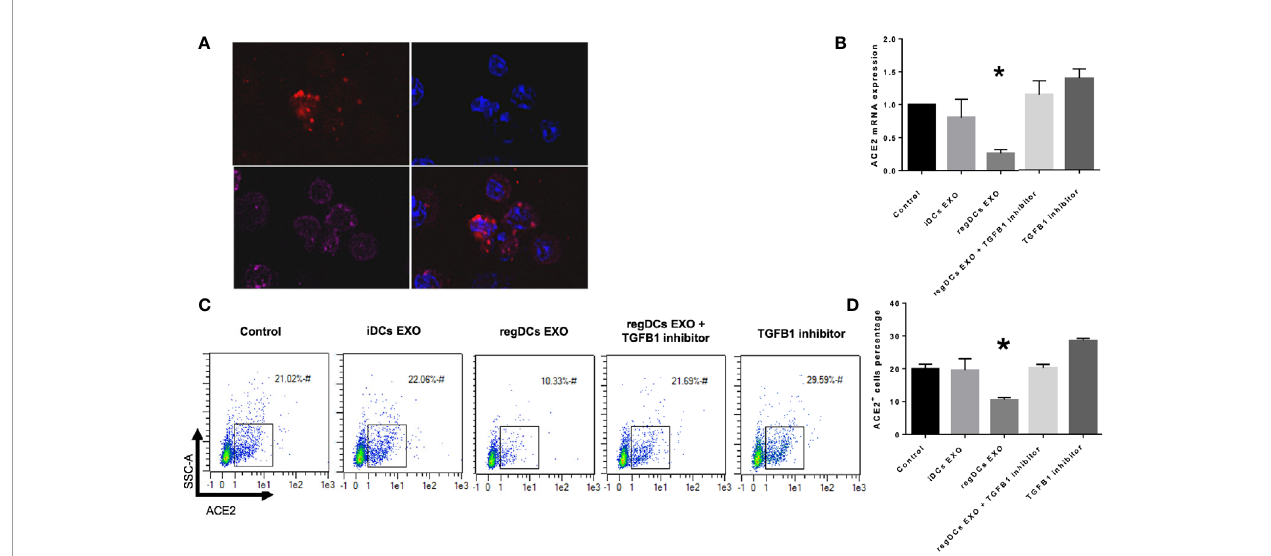
FIGURE 11 | regDCs EXO are taken up by acceptor PBTECs, inhibiting ACE2 expression in vitro. (A) Uptake of Dil labeled EXO (red) by PBTECs, counterstained with nuclear stain DAPI (blue), phalloidin (Alex fl our 647) for cell membrane and visualized under confocal microscopy. ACE2 mRNA expression (B) and fl ow cytometry scattergrams showing ACE2 positive cells percentage (C) in PBTECs treated or not treated with iDCs or regDCs EXO in the presence or absence of TGF b R1 inhibitor SB431542. (D) representative bar graph of (C) . Results shown are representative of three independent experiments (*P < 0.05 by one-way ANOVA followed by Tukey ’ s multiple